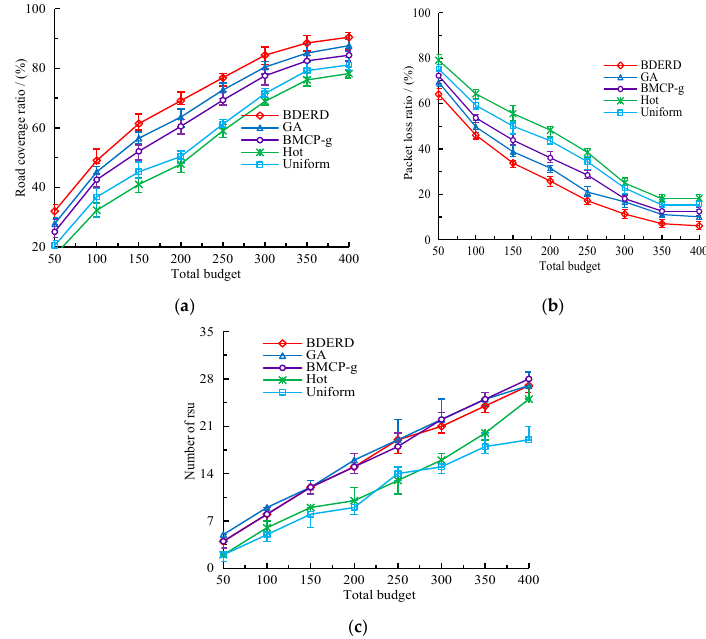
Figure 11. Realistic simulation. ( a ) Road coverage ratio versus the total budget; ( b ) packet loss ratio versus the total budget; ( c ) number of RSUs versus the total budget.